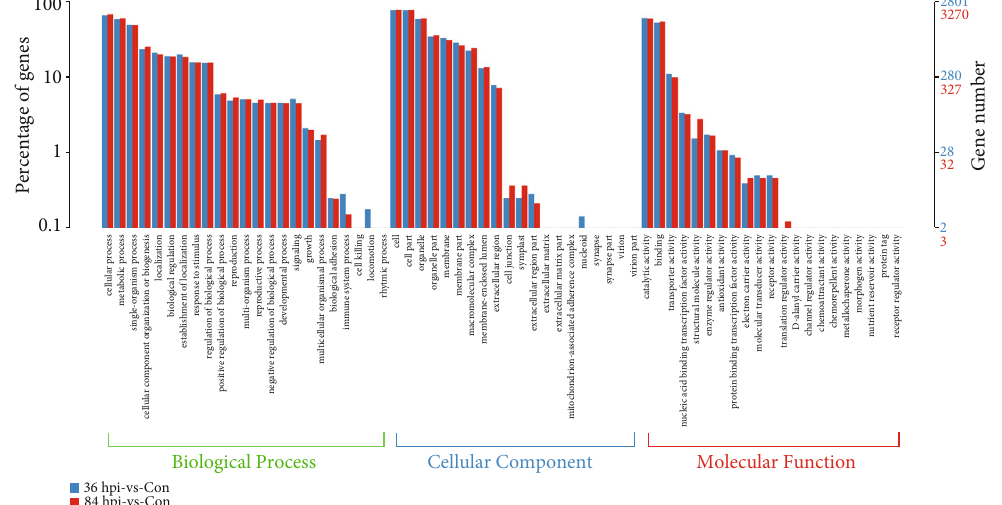
Figure 3: Functional annotation of the DEGs based on GO categorization. Blue columns represent the number of DEGs in 36hpi-vs-Con. Red columns represent the number of DEGs in 84 hpi-vs-Con. The x -axis has descriptions of the corresponding GO terms.